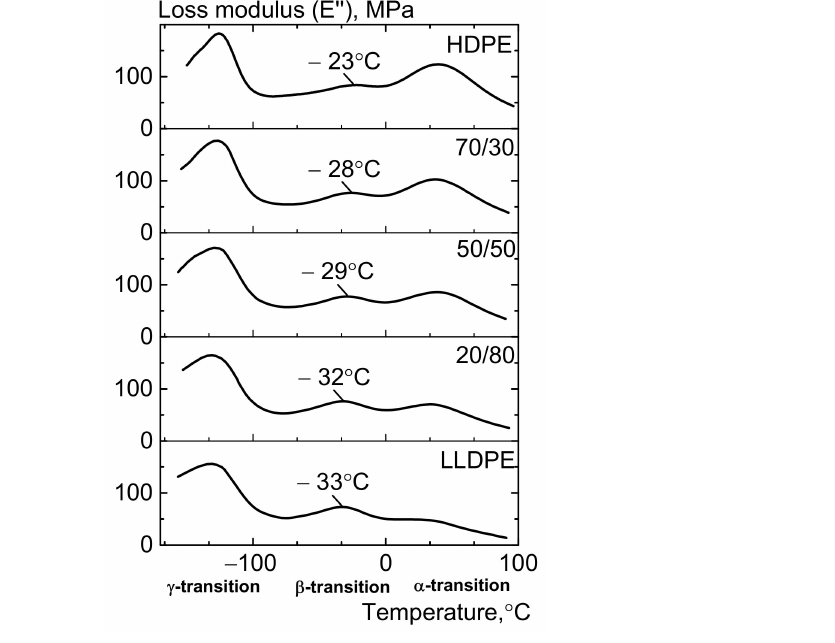
Figure 15. The effect of LLDPE on the loss modulus of the HDPE/LLDPE blends